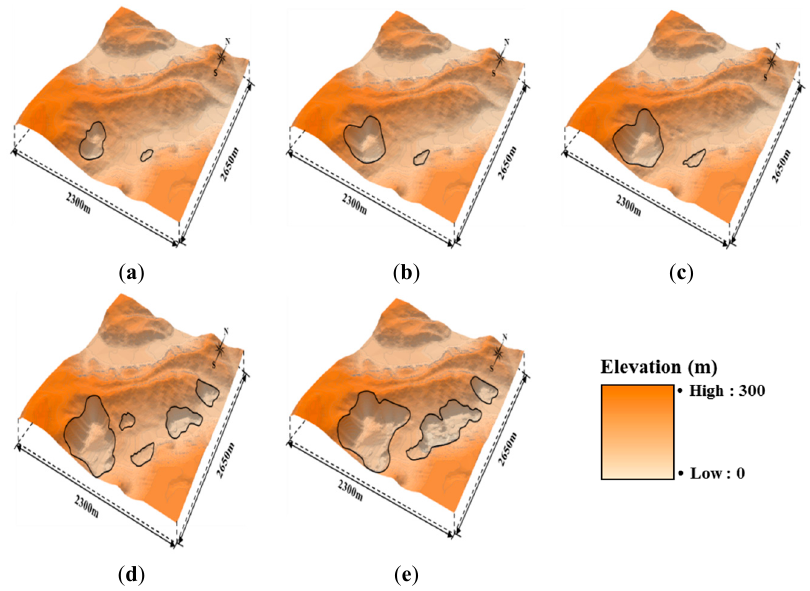
Figure 8. Pit optimization results using the floating cone algorithm. ( a ) Result No. 34 (Revenue Factor (RF) of Cu = 0.86, RF of Zn = 0.79); ( b ) Result No. 25 (RF of Cu = 1.01, RF of Zn = 1.00); ( c ) Result No. 55 (RF of Cu = 1.17, RF of Zn = 0.91); ( d ) Result No. 11 (RF of Cu = 1.34, RF of Zn = 1.58); ( e ) Result No. 21 (RF of Cu = 1.57, RF of Zn = 1.14).